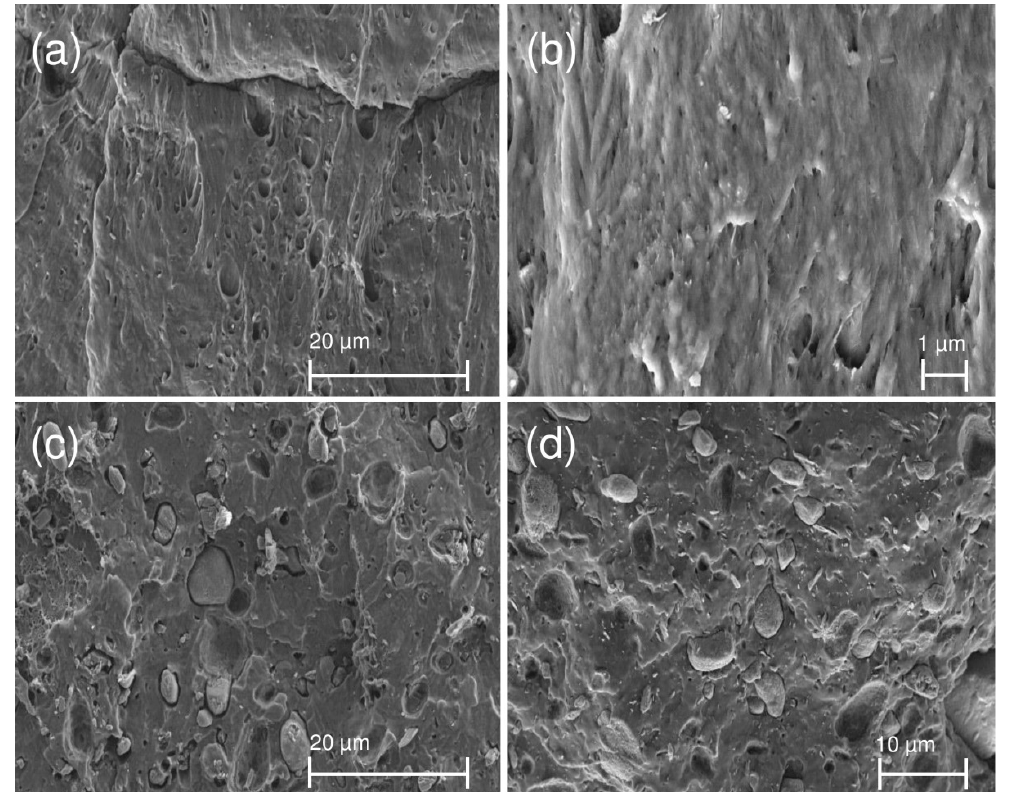
Figure 2. SEM images of PHB and its composites: ( a ) PHB; ( b ) PHB-Sep.; ( c ) PHB-APP; and ( d ) PHB- Figure2. SEMimagesofPHBanditscomposites: ( a )PHB;( b )PHB-Sep.;( c )PHB-APP;and( d APP-Sep.